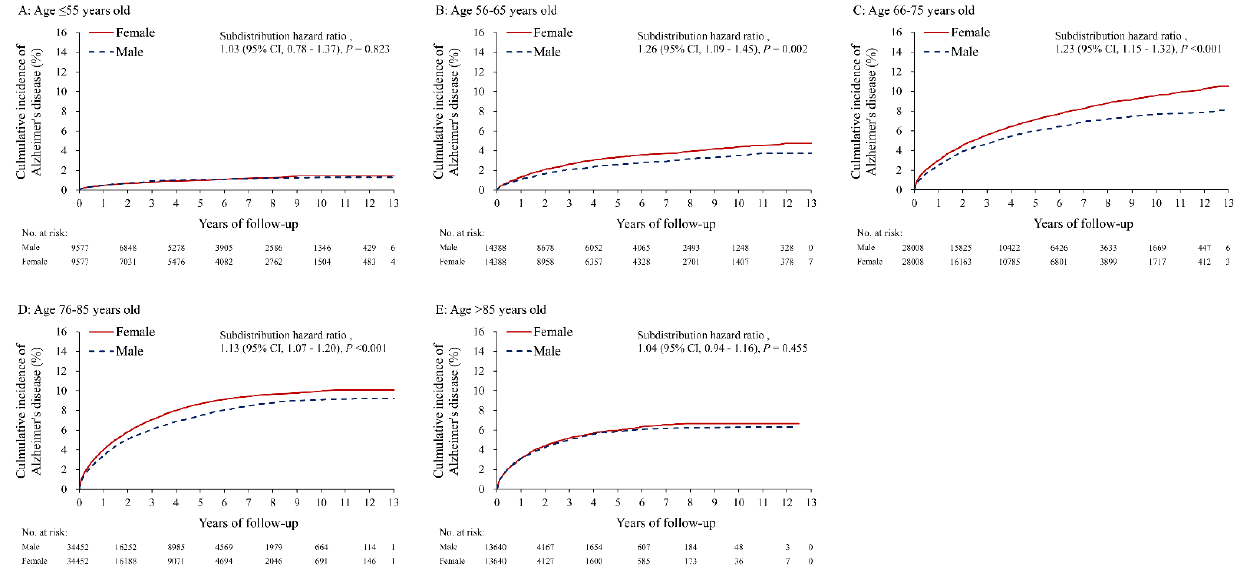
Figure 4. The cumulative incidence (under the Fine and Gray sub distribution model) of Alzheimer’s disease between male and female patients with atrial fibrillation stratified by age in the propensity score matched cohort. ( A ) age ≤ 55 years old,